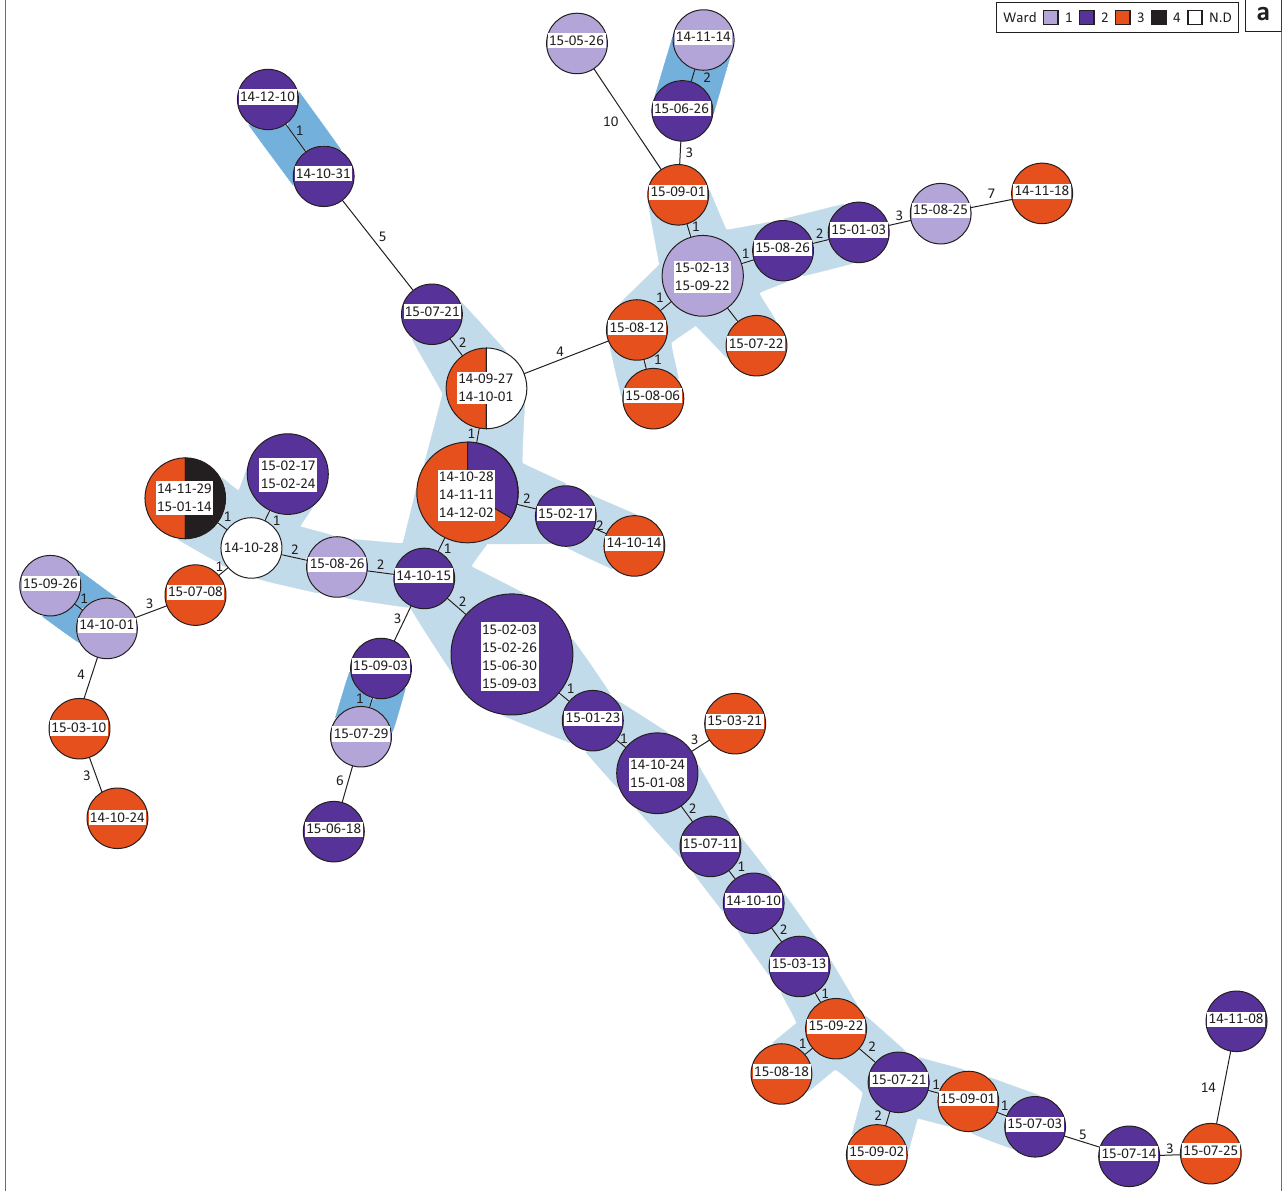
MLVA, multilocus variable-number tandem-repeat analysis; N.D., ward not recorded. FIGURE 3: Minimum spanning tree of MLVA data for C. difficile RT017 isolates showing their clonal relationships and isolation sites. Strains isolated from Hospital A (a) and Hospital B (b) are represented by circles with the date of isolation included in the circle and the circle colour representing the ward that the patient was in at the time of sample submission. Larger circles represent multiple identical isolates, with the size of the circle proportional to the number of isolates. The total summed tandem-repeat difference between strains is given by the numbers between each circle. Clonally related isolates (summed tandem-repeat difference ≤ 2) are grouped within the shaded areas – ( ) pairs, ( ) clusters. The trees have been redrawn for ease of viewing and are not to scale.